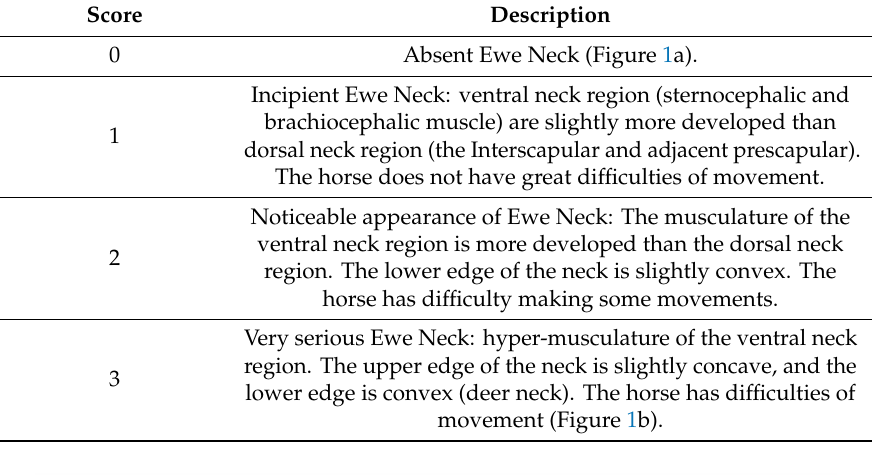
Table 2. Description of Ewe Neck scoring system in the Pura Raza Español Horse.